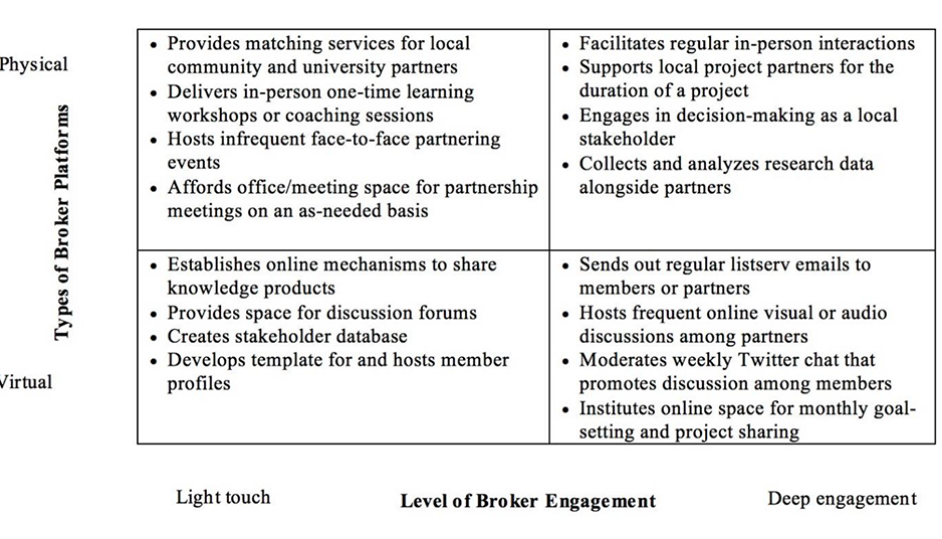
Broker initiative dimensions